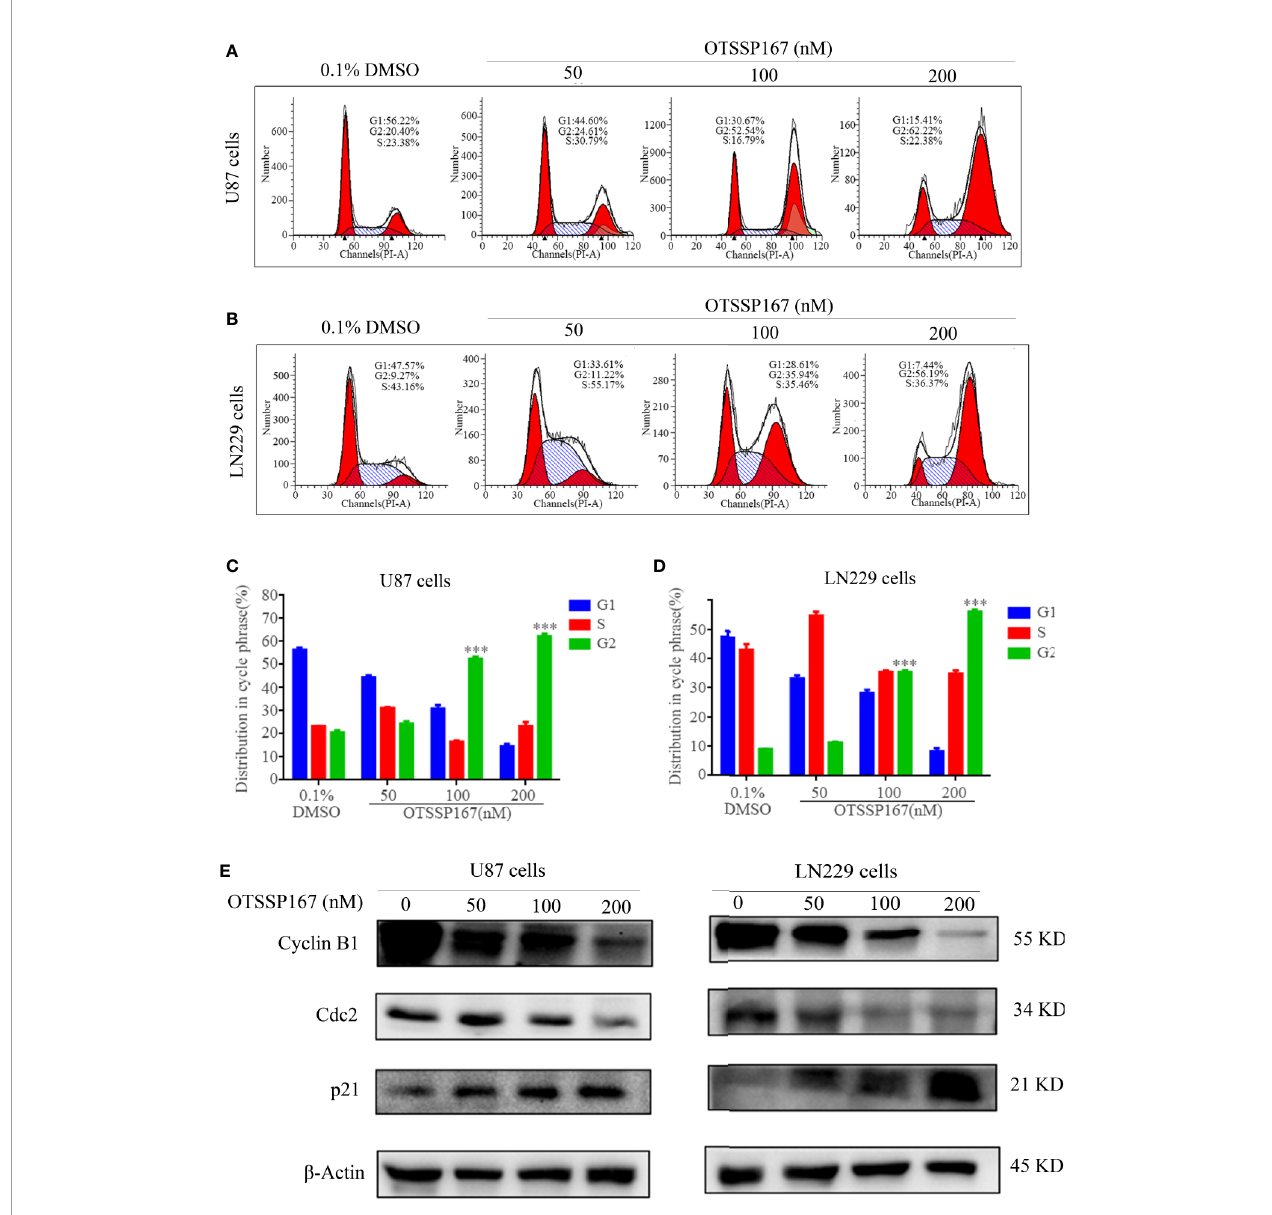
FIGURE 2 | OTSSP167 induces cell cycle arrest at the G2/M phase. (A, B) The U87 and LN229 cells were stained with PI after 24 h of OTSSP167 treatment. The results were assessed by fl ow cytometry. (C, D) Quantitative analysis of cell cycle phase distribution of cells in the control and the OTSSP167 treatment groups. (E) Western blotting analysis of cell cycle-related protein levels in U87 and LN229 cells treated with OTSSP167 for 24 h with indicated antibodies. All the Data are presented as means ± SEM. *** P